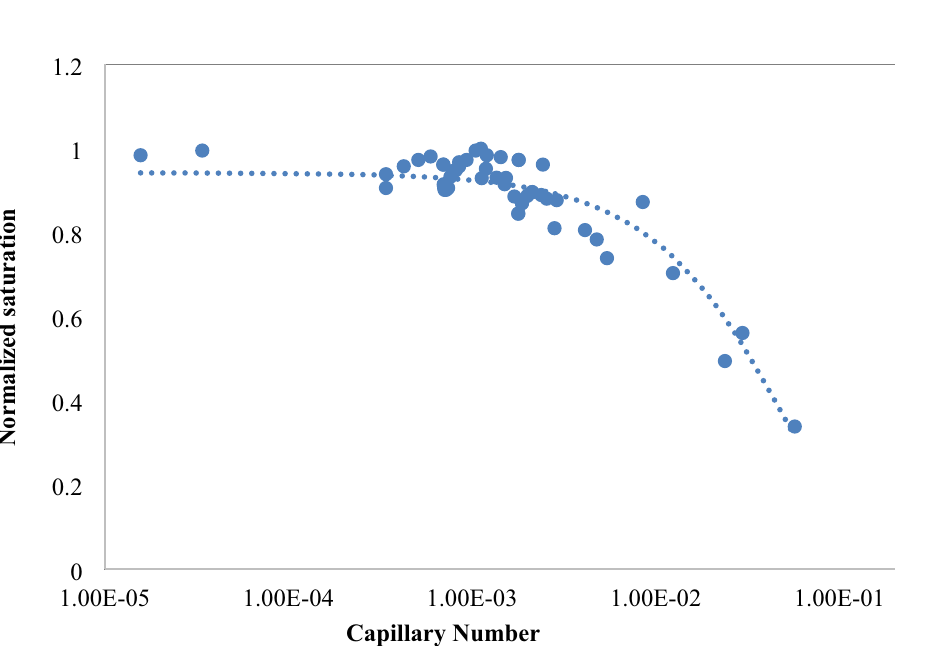
Figure 5. Variations of capillary number versus normalized water